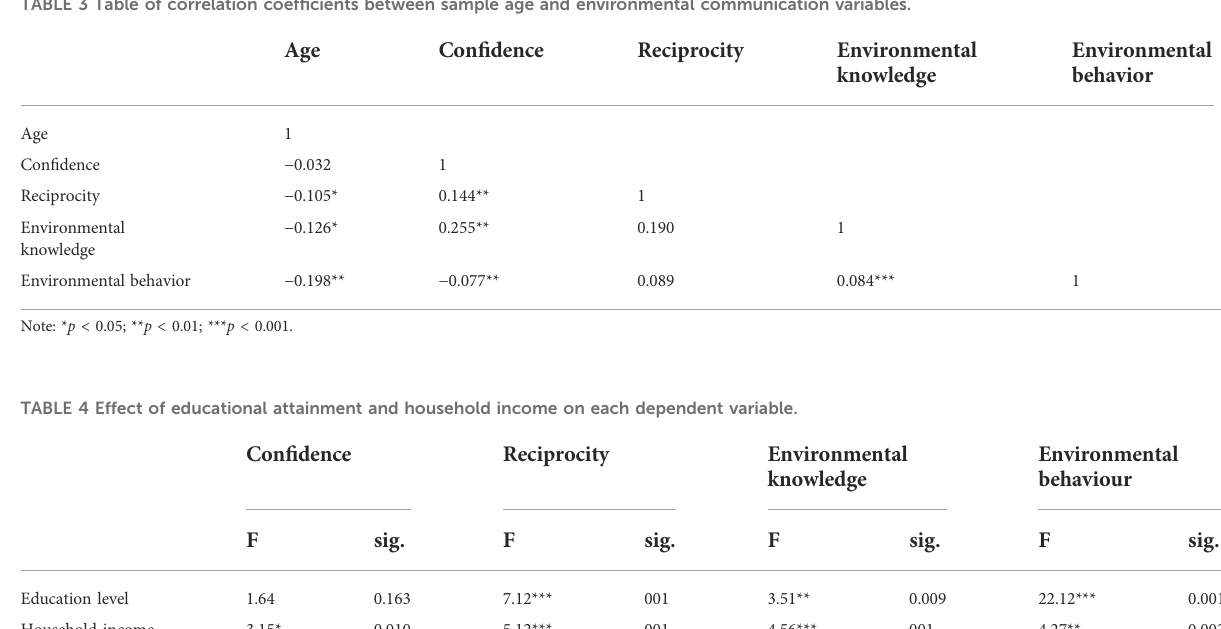
TABLE 3 Table of correlation coef fi cients between sample age and environmental communication variables.